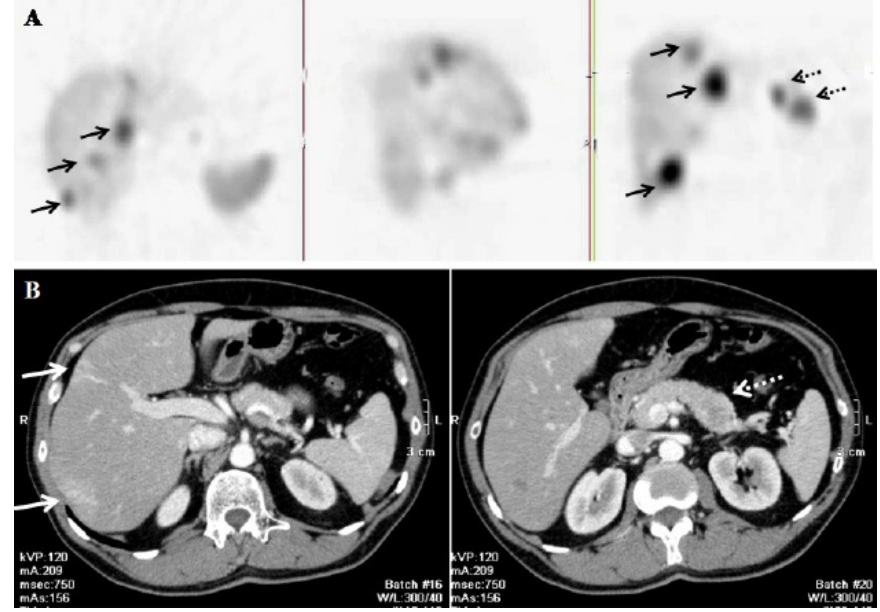
Figure 2: Well differentiated neuroendocrine carcinoma. Nonfunctional pancreatic carcinoid with liver metastases (Ki67 8.5%). A: